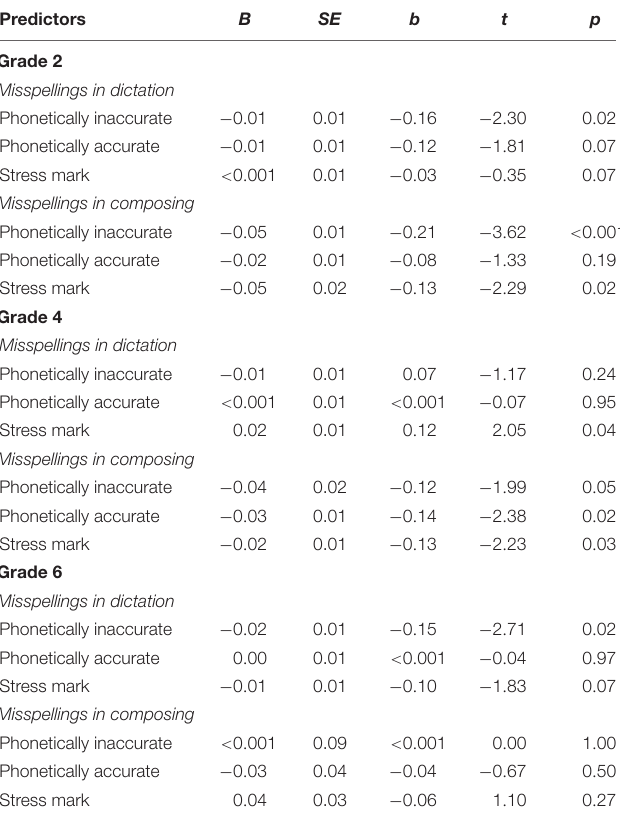
TABLE 3 | Parameter estimates for models regressing text quality onto misspellings by